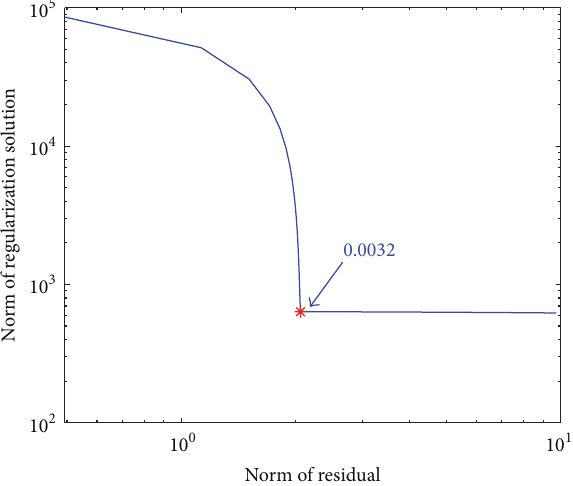
Figure 9: Identified impact load of SISO system.